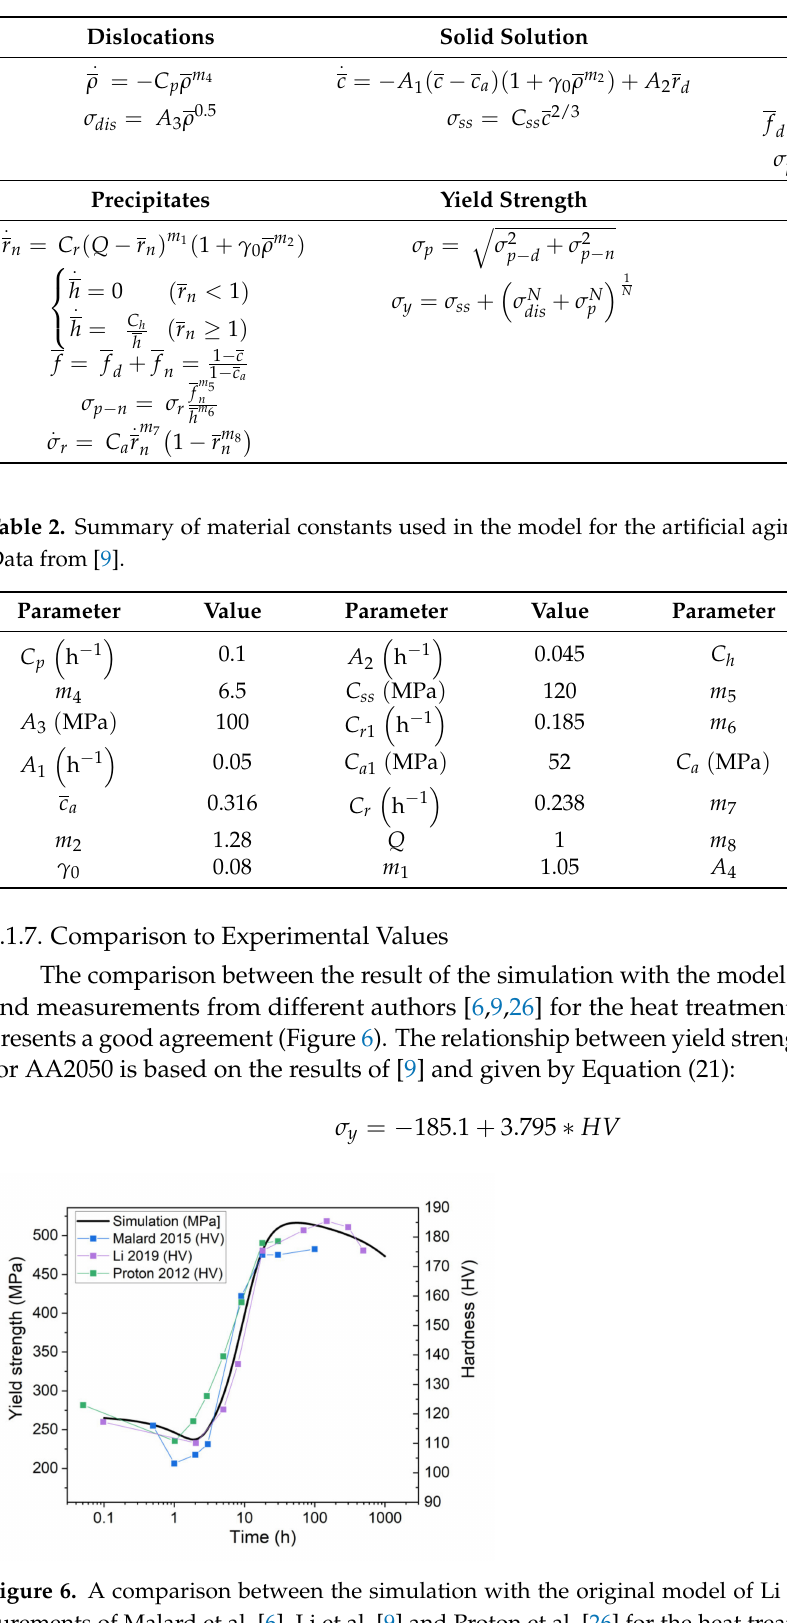
Table 1. Summary of the equations of the original model [9].